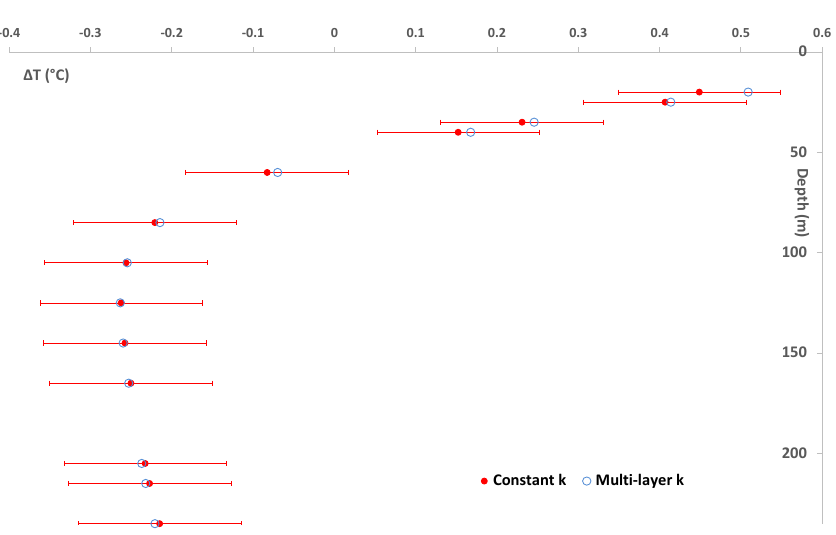
Figure 8. Effects of different thermal diffusivity used in the model. The temperature profiles a posteriori of 2015 obtained in the case of a constant thermal diffusivity value of the more widespread facies a (red dots) and in the case with multi-layer thermal diffusivities following the different facies according to Fig. 6 (blue dots). The bars indicate the variations in the measured temperature in the same